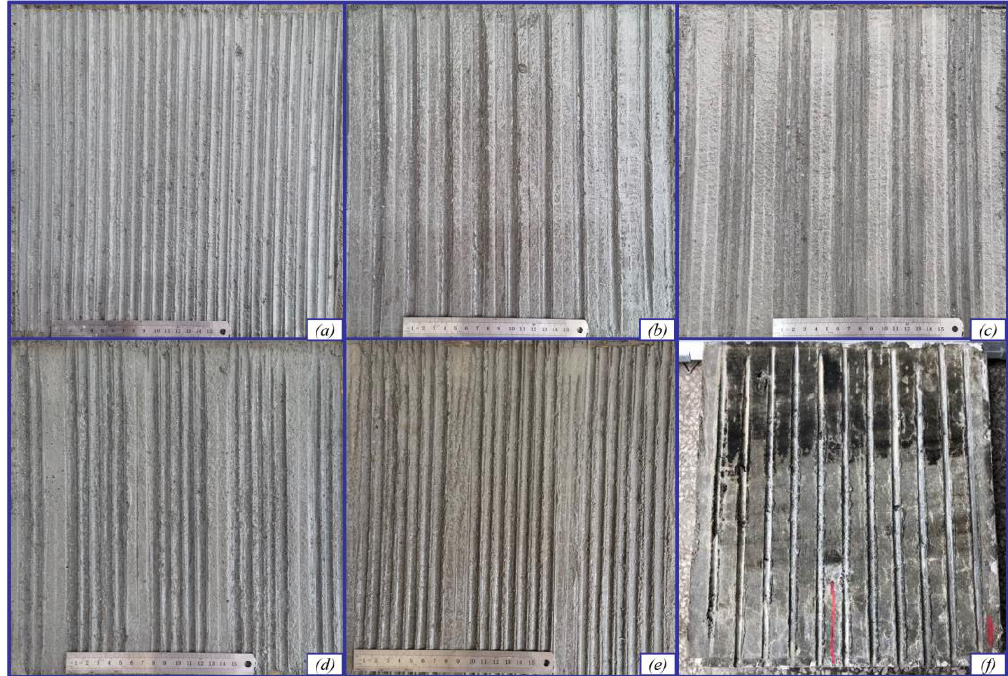
Table 8. Test specimen parameters.